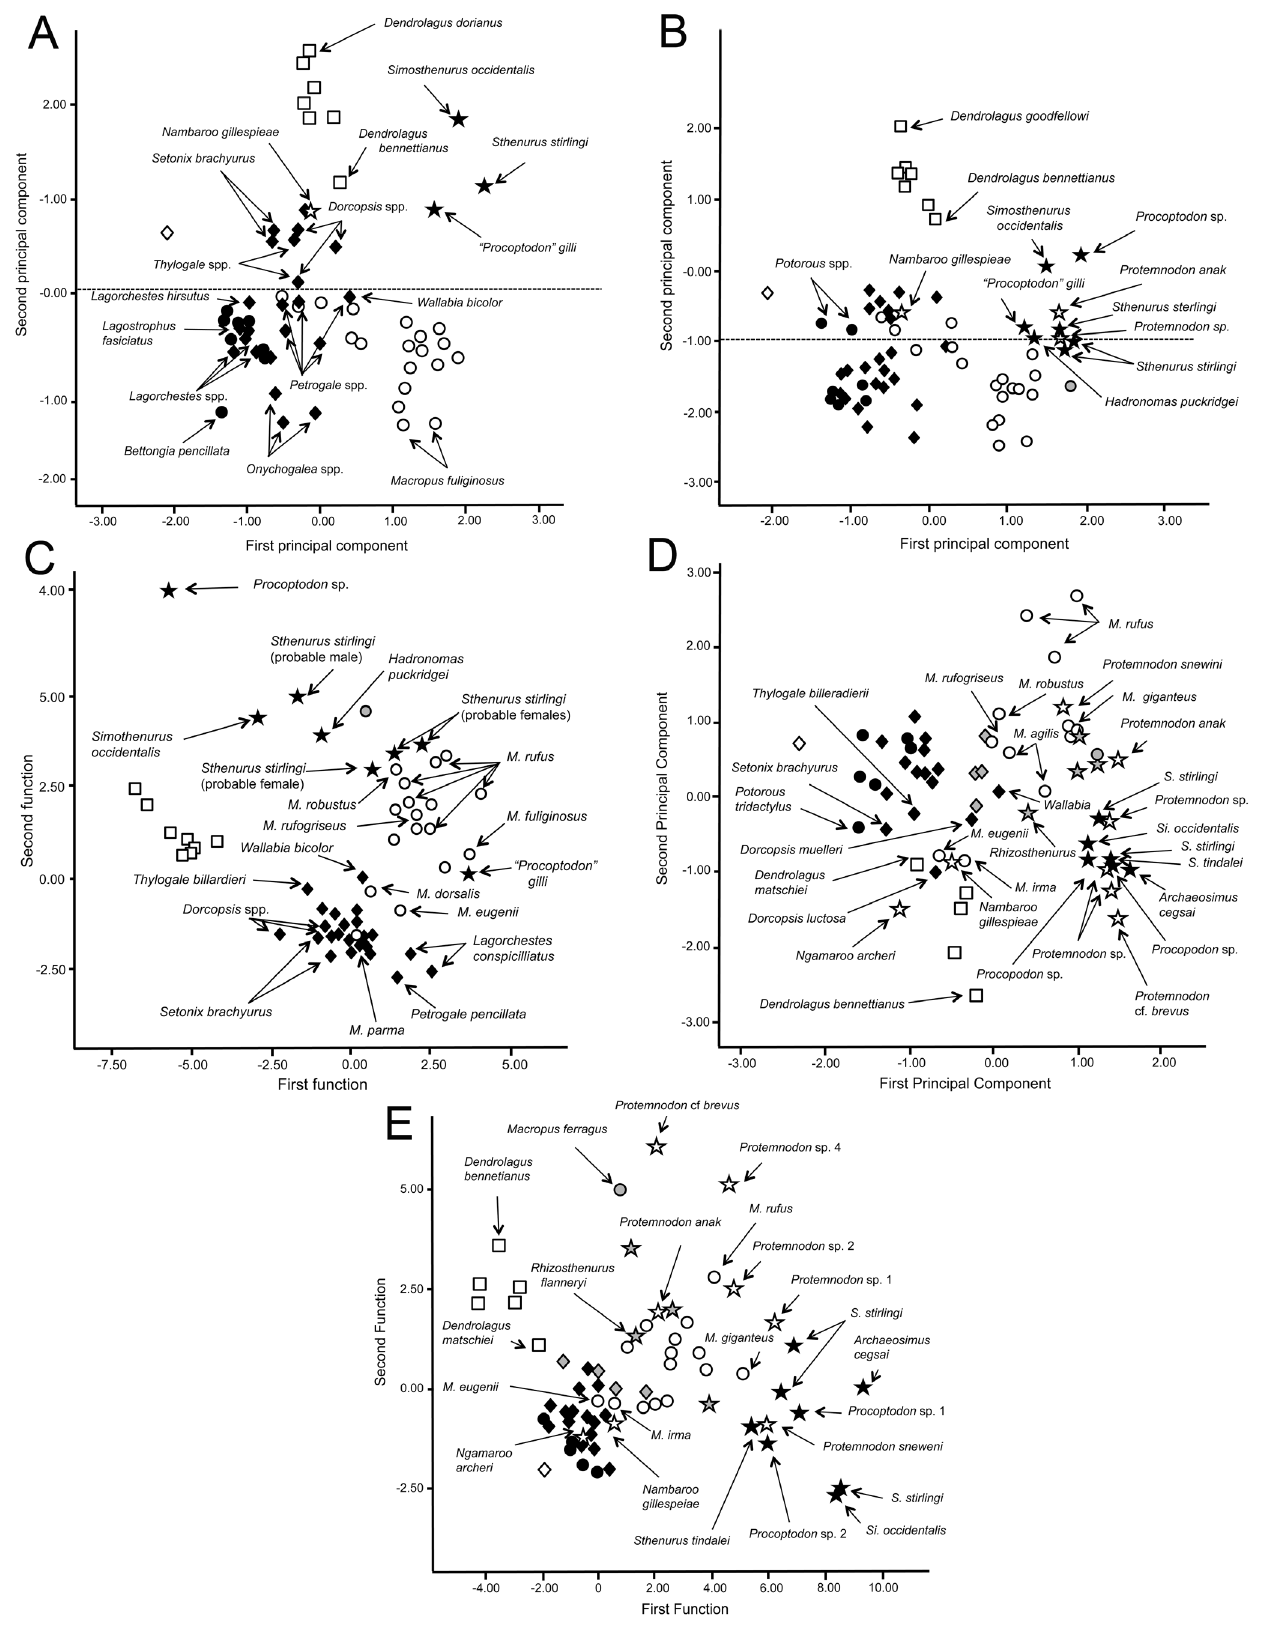
Figure 11. Multivariate analyses of hindlimb bones. Key as for Figure 10: taxa included and explanation of any composite fossils are listed and explained in Tables S3, 4. (A) Principal Components Analysis using all hind limb bones. The dotted line indicates the division between extant taxa that